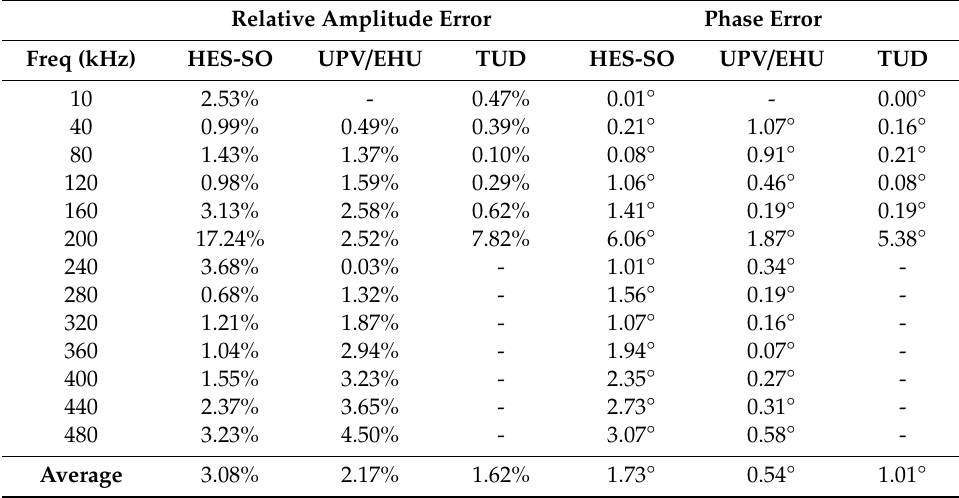
Figure 7. Comparison of simulations and measurement results for filter Reference 2055: (up) magnitude, (down) phase of the impedance. Table 4. Accuracy of the methods in the measurement of filter 2060, with respect to the results obtained by the impedance precision